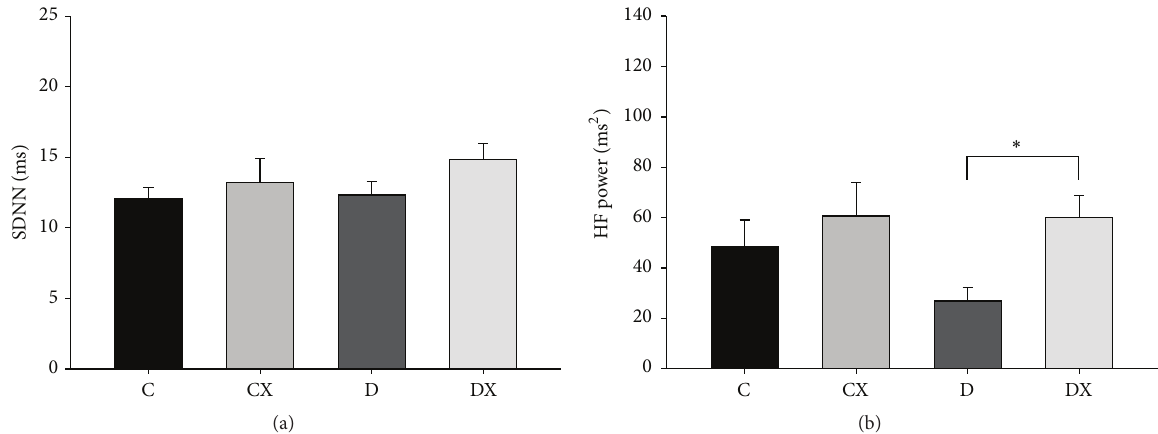
Figure 4: (a) Total HRV (SDNN) at week 10: C, sedentary control ( 𝑛 = 5 ); CX, control exercise ( 𝑛 = 7 ); D, sedentary T1DM ( 𝑛 = 8 ); DX, T1DM exercise ( 𝑛 = 8 ). (b) High Frequency (HF, parasympathetic) HRV component at week 10: C ( 𝑛 = 6 ); CX ( 𝑛 = 7 ); D ( 𝑛 = 8 ); DX ( 𝑛 = 8 ). ∗ Significantly different groups ( 𝑝 < 0.05 ). Data are mean ±